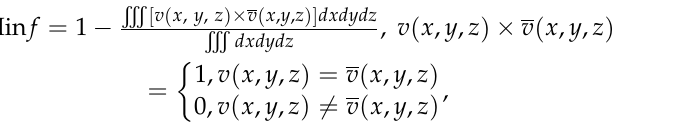
(2) where 𝑉 (cid:3036) indicates the sequential points on the contour, and k is half the width of the selected interval in 𝑉 (cid:3036) . The turning points were local maximum bending in a given inter- val of 2 k and its bending value was larger than the given criteria of 1.8 × k in this case, and γ was set to 0.4. P 1 is the geometric mean of the turning points, P 2 is the centroid of the vertebra projected onto the OSP, and P 3 is the maximum z -value vertex of the vertebra projected onto the OSP.